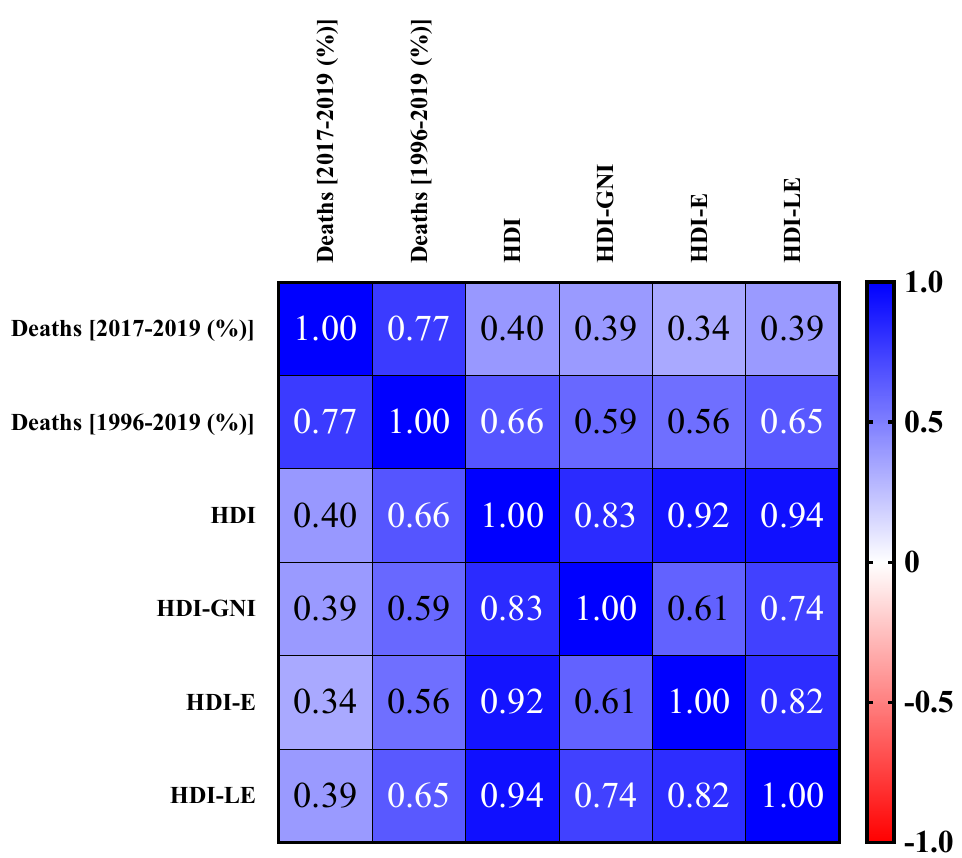
Figure 4. Correlation between the number of deaths from cystic fibrosis (CF) in the 2017–2019 period and the Human Development Index [HDI, HDI—education (HDI-E), HDI—gross national index (HDI-GNI), and HDI—life expectancy (HDI-LE)]; and between the number of deaths from CF in the 1996–2019 period and HDI, HDI-E, HDI-GNI, and HDI-LE. The Spearman correlations considered the following cut-off points: (i) ± 0.90–1.0, very high positive–negative correlation index; (ii) ± 0.70–0.90, high positive–negative correlation index; (iii) ± 0.50–0.70, moderate positive–negative correlation index; (iv) ± 0.30–0.50 low positive–negative correlation index; and (v) 0.00–0.30, insignificant positive–negative correlation index. An alpha error of 0.05 was used in the statistical analysis. %, percentage. Table 1. Characterization of deaths and new diagnoses of cystic fibrosis in Brazil according to the